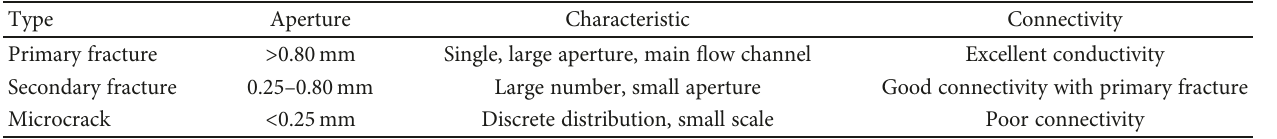
Table 1: Classi fi cation criteria of fractures.